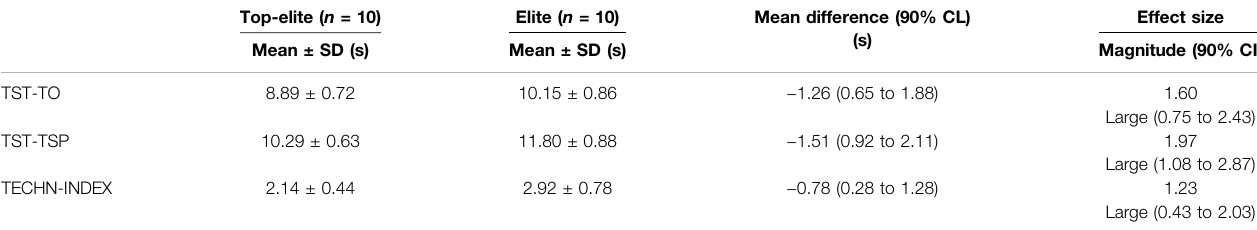
TABLE 3 | Comparison of TST performance and TECHN-INDEX between top-elite and elite taekwondo athletes. Top-elite ( n = 10) Elite ( n = 10)